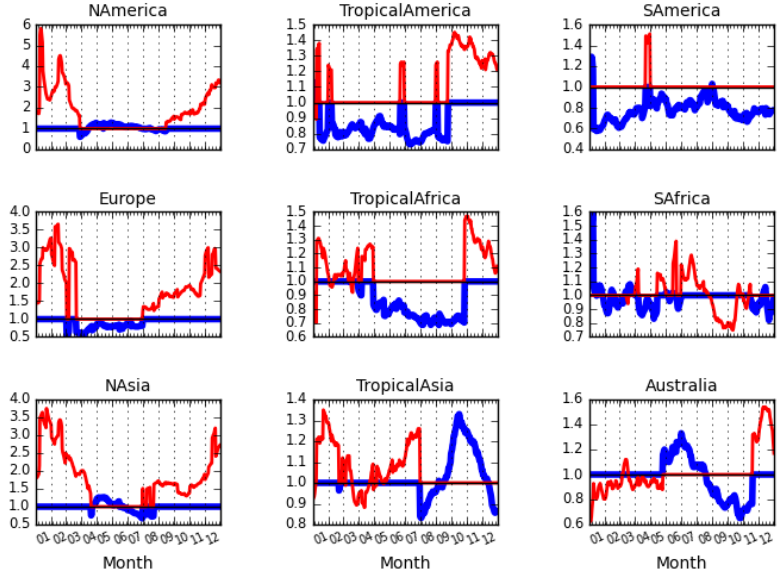
Figure 5. Time series of GPP and R eco flux scaling factors in blue and red lines, respectively, for the crop vegetation type in 2010 in the different regions (see map in Fig. 3 depicting the extent of the crops within each